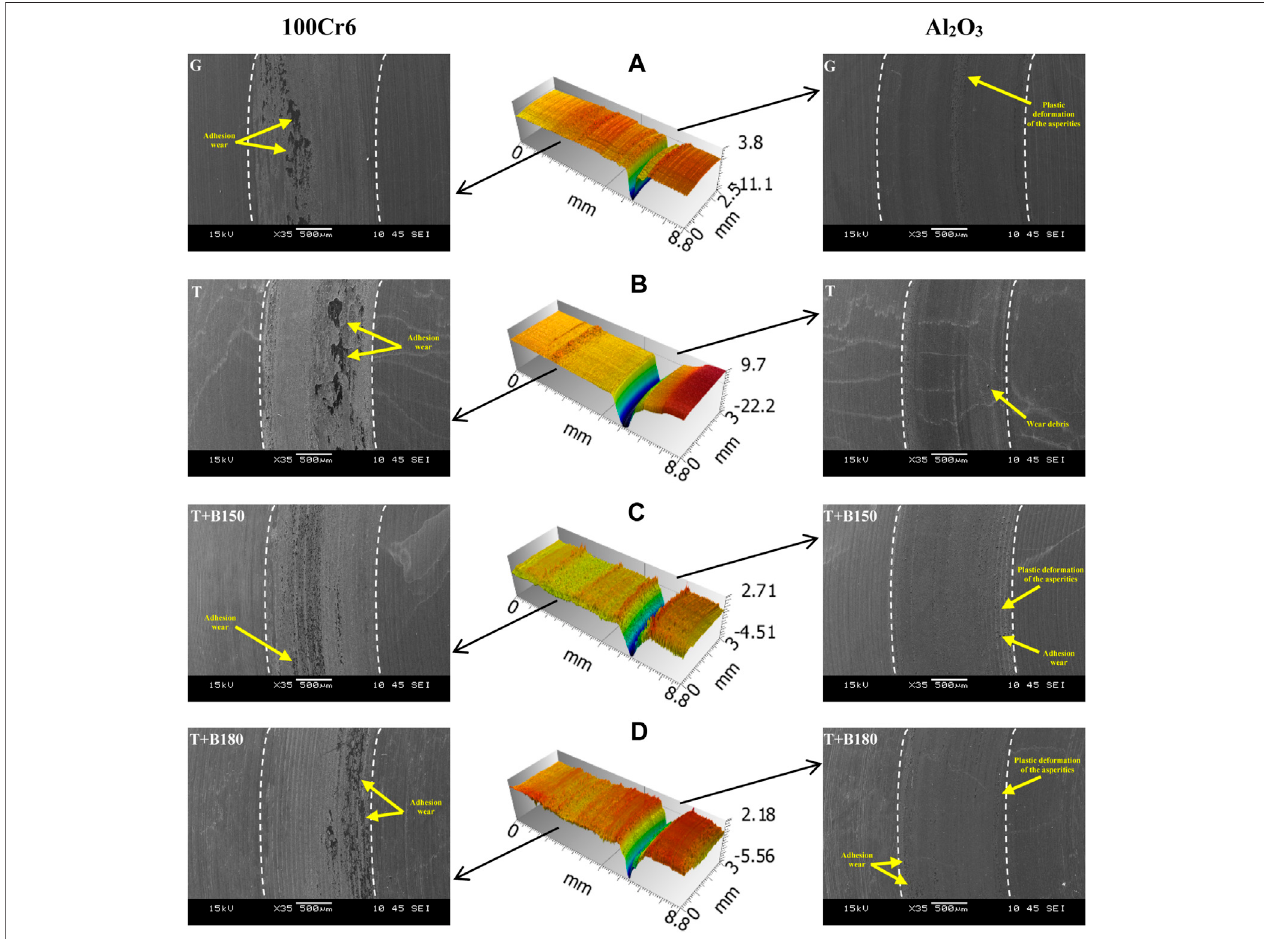
FIGURE 12 | Examples of the pro fi lograph running s across the track following the wear as well as images of wear (after ball-on-disc test) for Vancron 40 tool steel after different surface treatments: (A) G, (B) T, (C) T + B150, (D) T + B180.